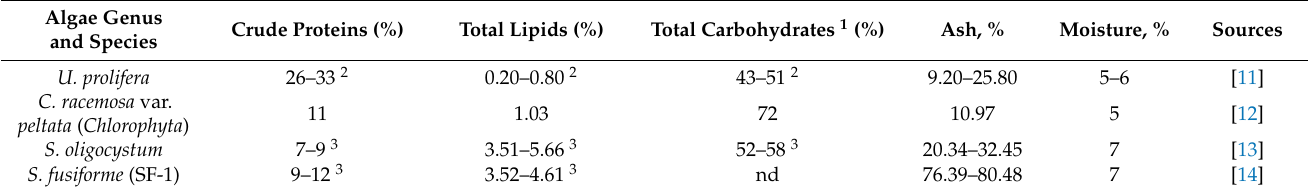
Table 1. Nutritional value of marine algae in terms of dry matter